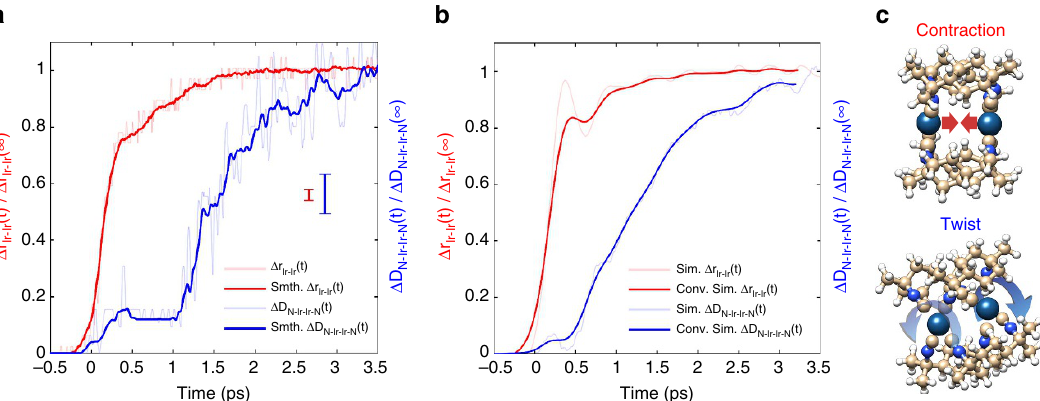
Figure 2 | Molecular structural dynamics of photoexcited [Ir 2 (dimen) 4 ] 2 þ . ( a ) The Ir–Ir contraction (red) and the N-Ir-Ir-N dihedral twist (blue) determined from the XDS analysis. The full curves show the 15-point ( B 120fs) smoothed result, with the parameter uncertainty being estimated by the point-to-point variation. Vertical lines show the average standard error at each time delay. ( b ) Ir–Ir contraction (red) and N-Ir-Ir-N dihedral twist (blue) determined from BOMD simulations (shaded lines) and the results from BOMD after convoluting the signal with the IRF of the experiment (full lines). ( c ) Schematic depiction of the contraction and twist